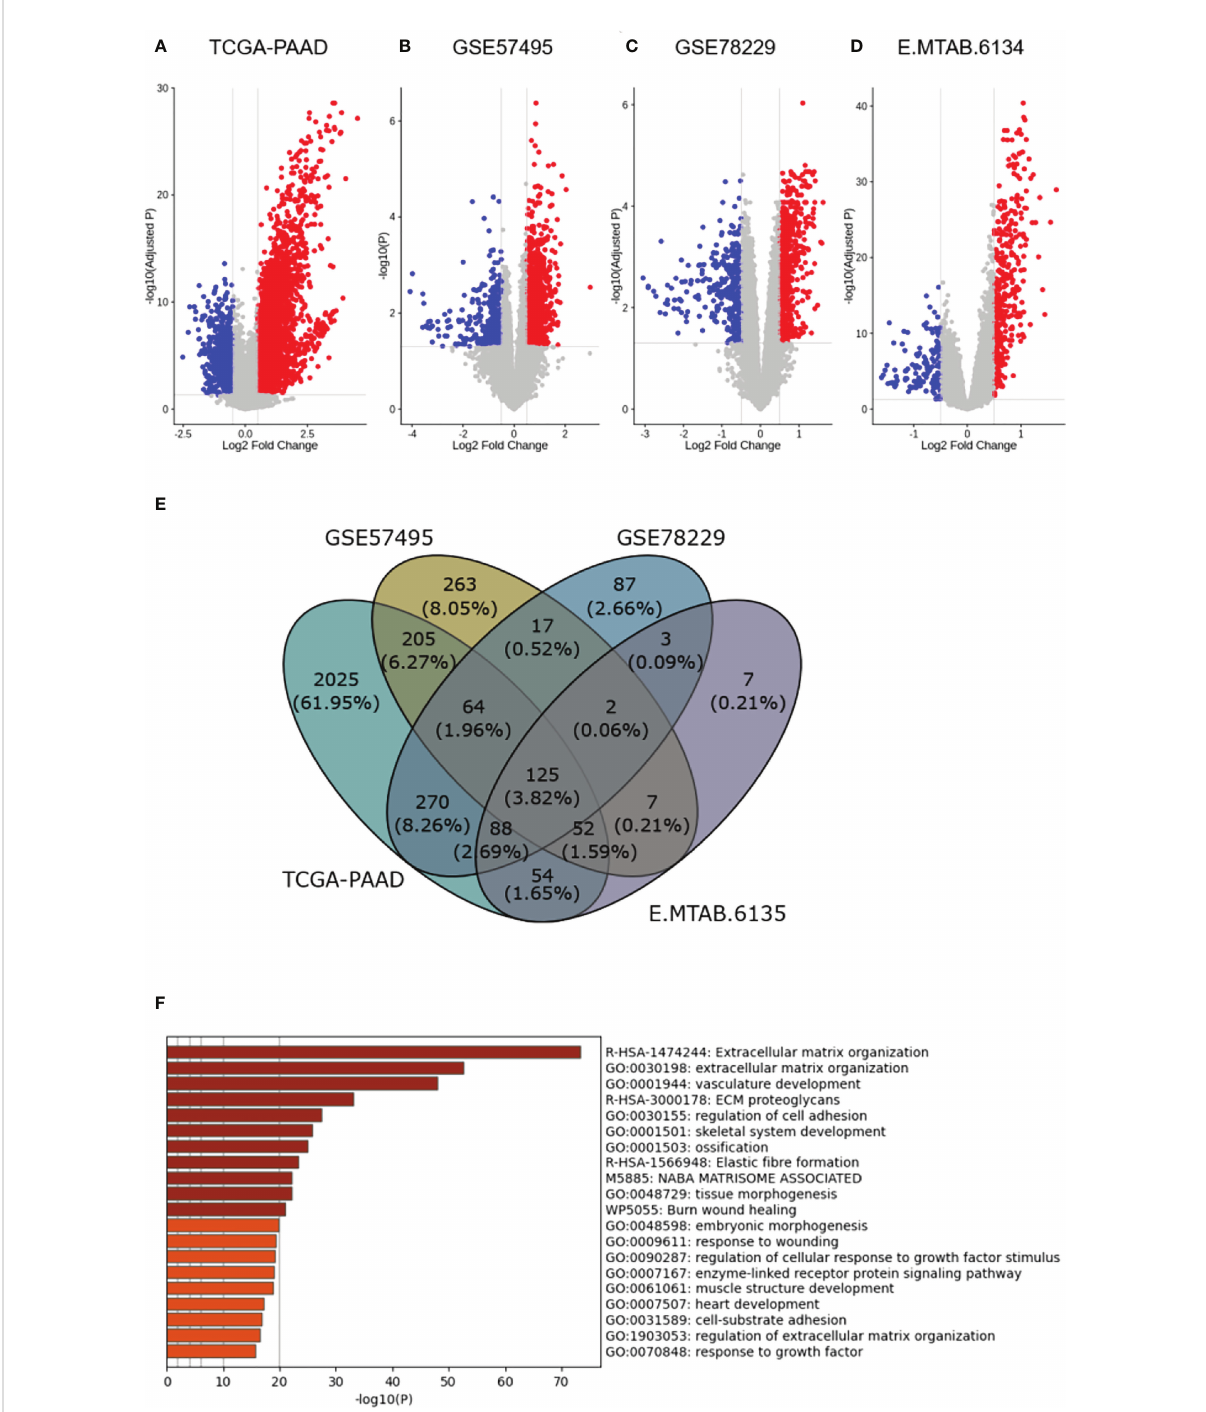
FIGURE 2 Differential expression analysis. (A – D) , Volcano plots representing differential expression analysis results among the high- and low-risk PDAC patients in the studied datasets (TCGA-PAAD, GSE57495, GSE78229, and E-MTAB-6134 respectively). (E) , Venn diagram shows 125 differentially- expressed genes overlapping between all four datasets. (F) , Overrepresented gene analysis reveals a gene set involved in “ Extracellular matrix reorganization ” to have the highest relevance to the identi fi ed dysregulated